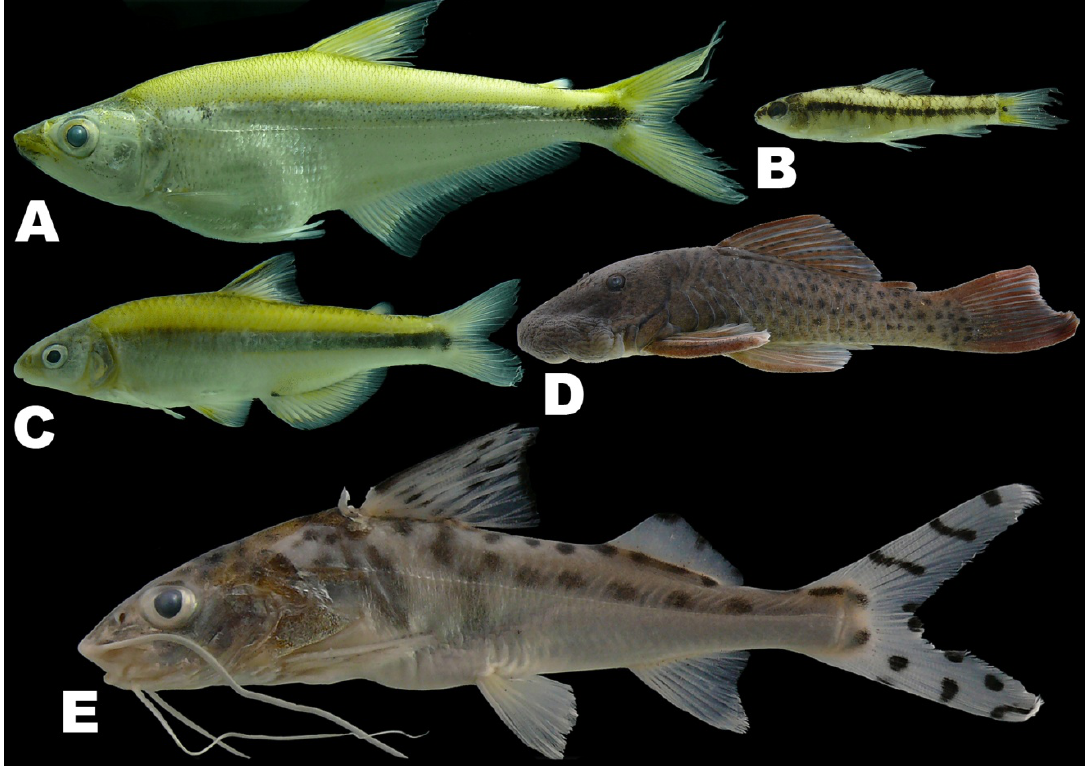
Figure 6. Examples of species collected only in the Alto Ucayali. (A) Acestrocephalus boehlkei (79 mm). (B) Geryichthys sterbai (26.7 mm). (C) Attonitus ephimeros (48 mm). (D) Chaetostoma lineopunctatum (52 mm). (E) Pimelodus pictus (78